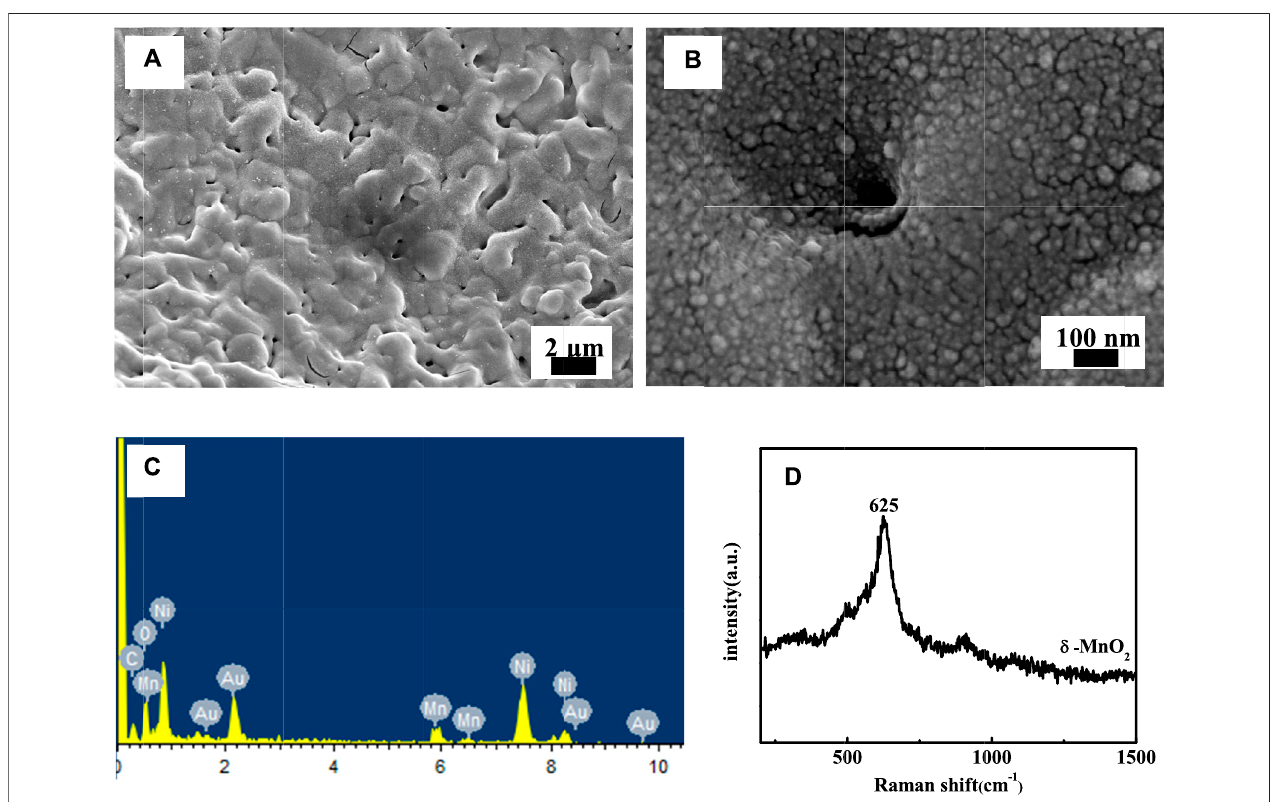
FIGURE 2 | (A) Low- and (B) high-magni fi cation SEM images of MPNF-MnO 2 electrode. (C,B) are the EDX analysis and Raman spectra of the MPNF-MnO 2 electrode, respectively.